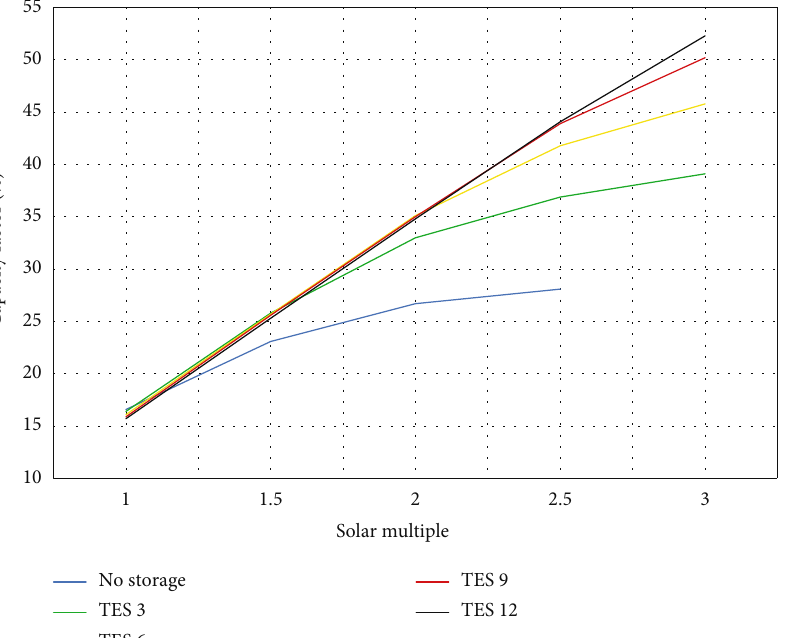
Figure 6: Capacity factor for varying SM and hours of TES.